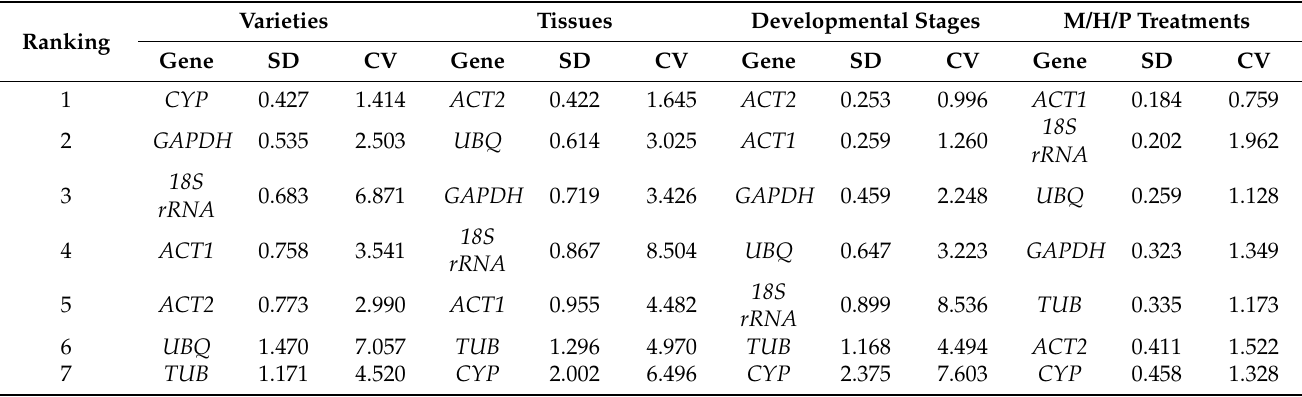
Table 5. Average expression stability values of seven candidate reference genes as calculated by BestKeeper. M/H/P treatments means MT, HBR or PP